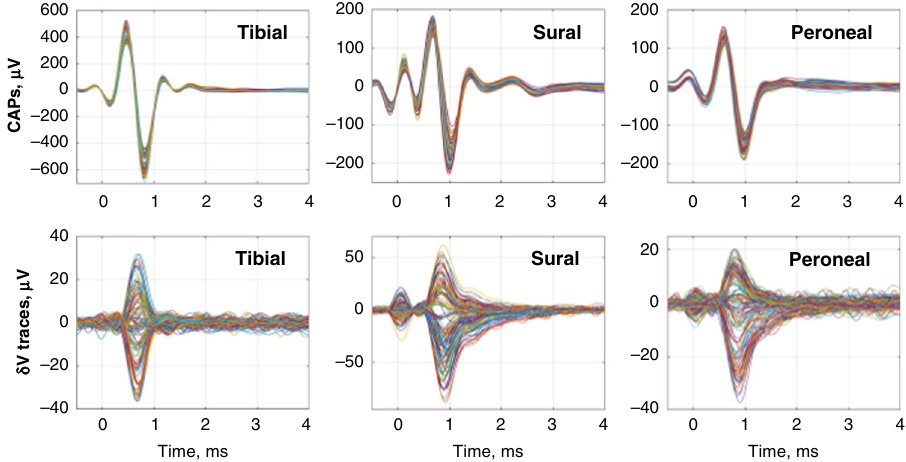
Fig. 2 Representative compound action potentials (CAPs) and δ V traces. CAPs were recorded on all 14 electrodes of the EIT cuff; δ V traces were recorded on 14 electrodes × 14 current injections = 196 for tibial, sural, and peroneal fascicles. Source data are